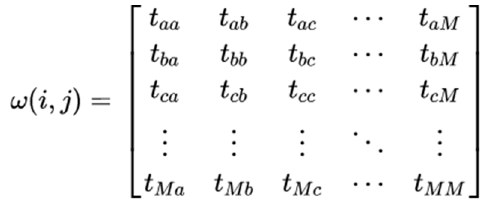
Algorithm 1 The Floyd – Warshall’s shortest path